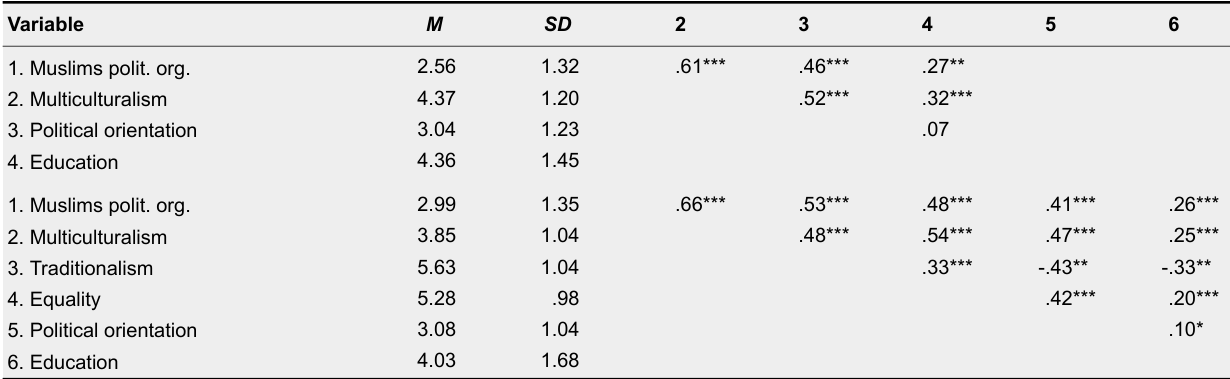
Descriptive Findings and Correlations of the Main Variables From Studies 1 (First Four Rows), and 2 (Last Six